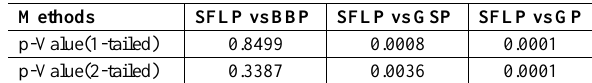
Table 6. Results of the multiple-problem